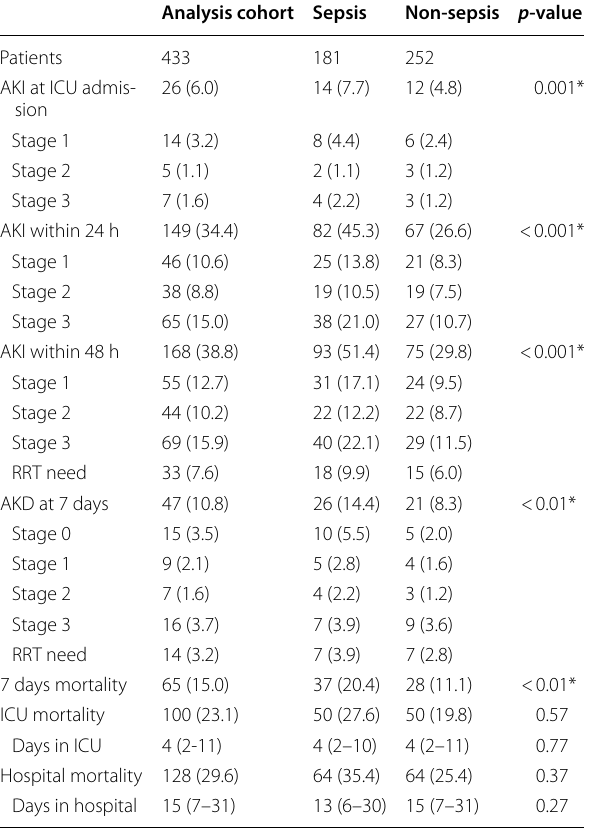
Table 2 Patients’ outcomes in the overall population and in septic and non-septic